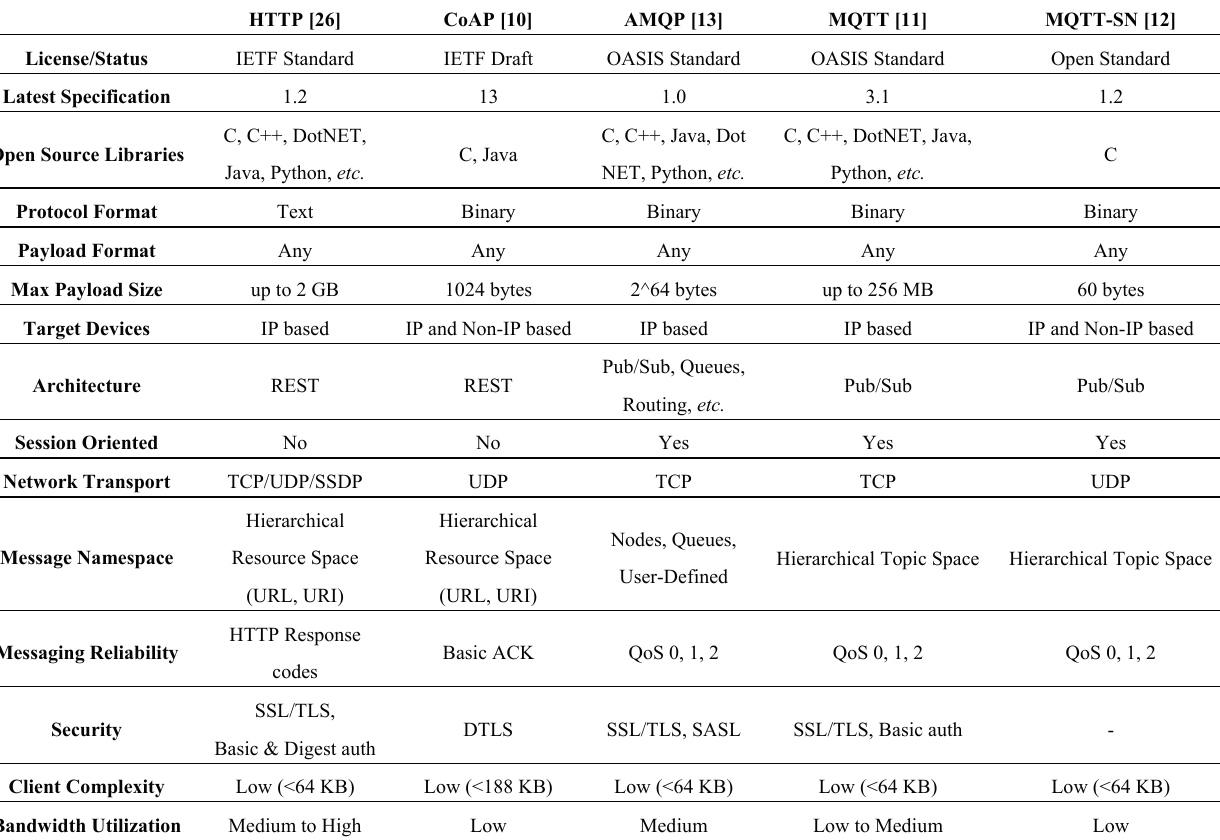
Table 2. Key enabling M2M communication protocols for future mHealth